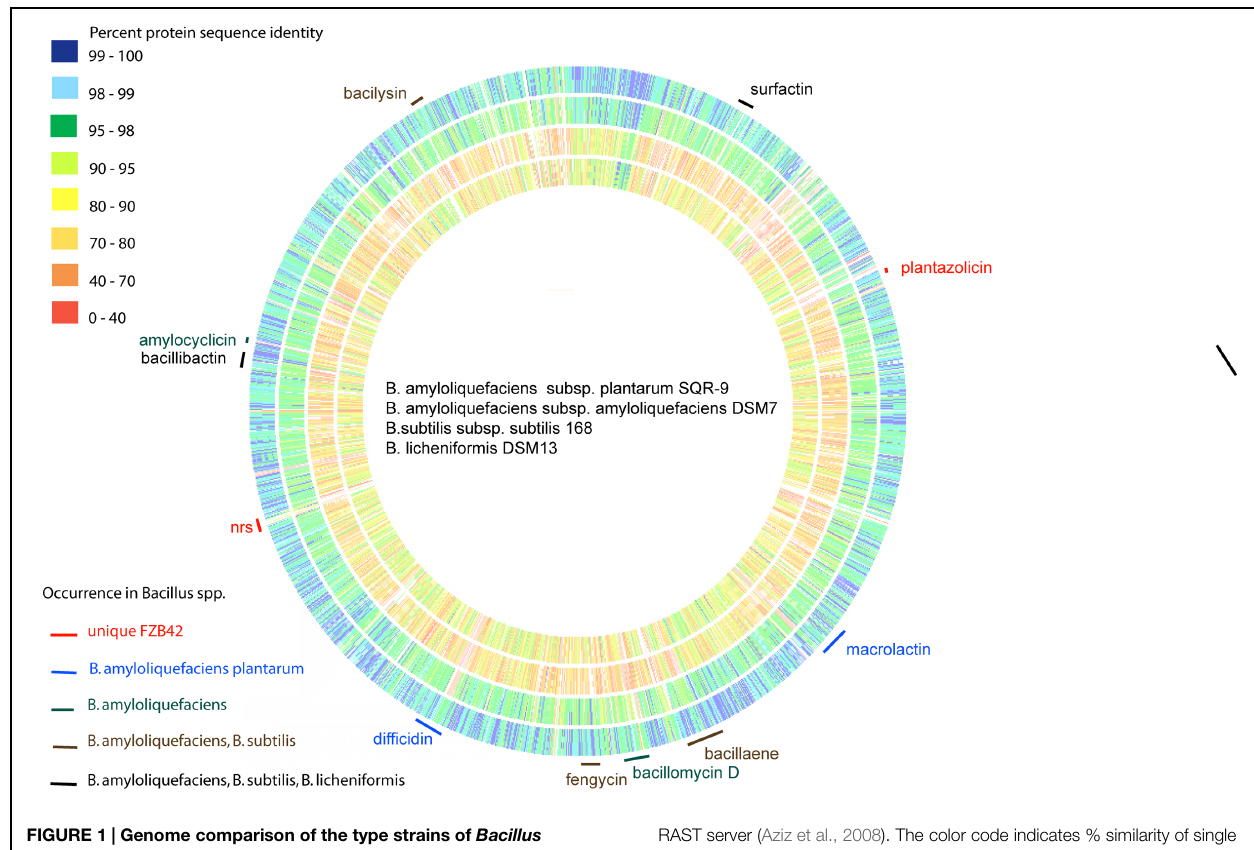
RAST server (Aziz et al., 2008). The color code indicates % similarity of single gene products. The gene clusters responsible for non-ribosomal synthesis of the polyketides macrolactin and difficidin are unique in B. amyloliquefaciens subsp. plantarum . The iturin gene cluster (bacillomycin D) occurs also in B. amyloliquefaciens subsp. amyloliquefaciens